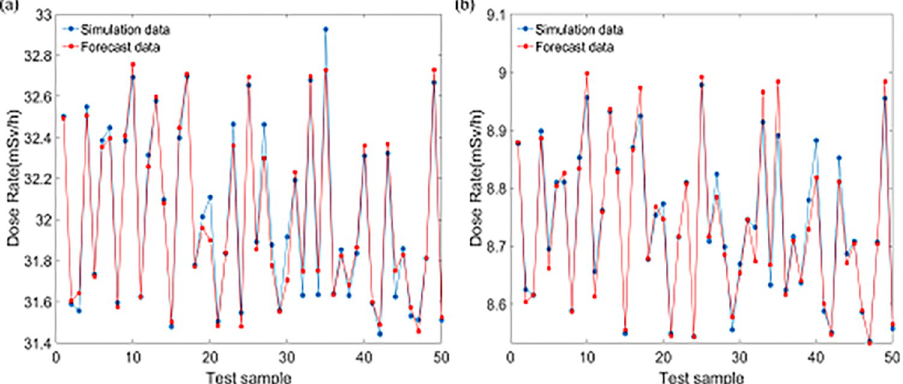
Fig 4. Comparison between simulation and the model results: (a) Co-60, (b)